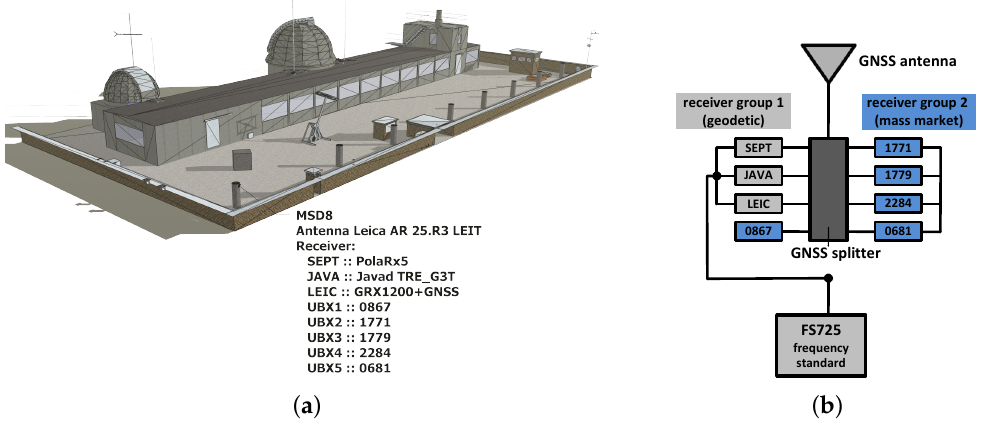
Figure 2. Zero baseline set-up to study the equipment-specific characteristics of consumer market GNSS receivers; laboratory network ( a ) and configuration of receiver groups ( b